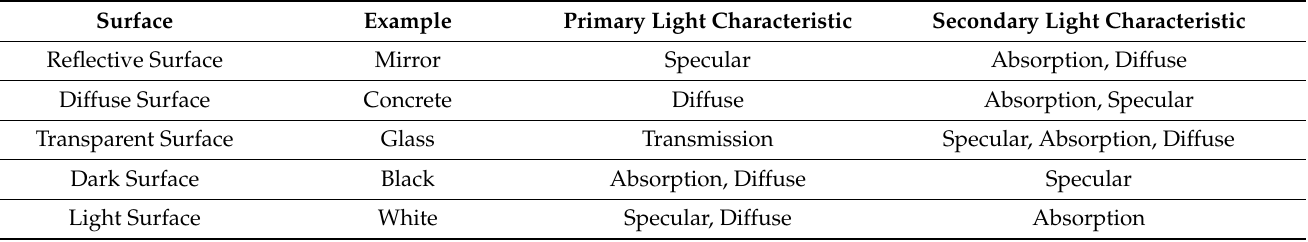
Table 1. Reflective behaviors of various surfaces.